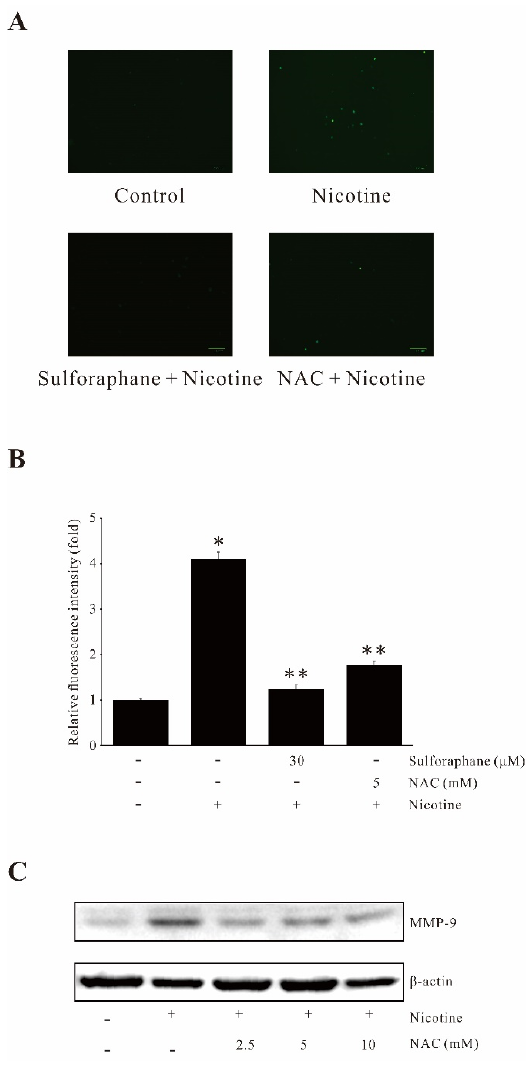
Figure 2. Sulforaphane inhibits nicotine-induced ROS in human gastric cancer AGS cells. ( A ) AGS cells were pretreated with 30 μ M sulforaphane and 5 mM NAC for 1 h prior to nicotine treatment for 30 min. The cells were then incubated in the dark for 10 min with 10 μ M H 2 DCFDA. The H 2 DCFDA fluorescence was imaged using a confocal laser scanning fluorescence microscope. ( B ) Relative fluorescence intensities of the ROS production level. ( C ) Cells pretreated with NAC (2.5, 5, 10 mM) for 1 h were incubated with nicotine (100 μ g/mL) for 12 h. After incubation, extracted proteins were analyzed for the induction of MMP ‐ 9 expression by Western blot. The data represent the mean ± SEM from three experimental trials. * p < 0.05 in comparison with the control; ** p < 0.05 in comparison with nicotine alone.